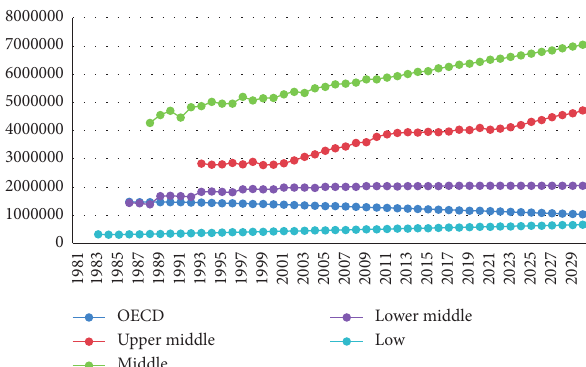
Figure 2: Forecasted values of methane emission (in kt of equivalent CO ) under the BJ method. Source: drawn by the 2 authors. Figure 3: Forecasted values of agriculture output (in current USD)